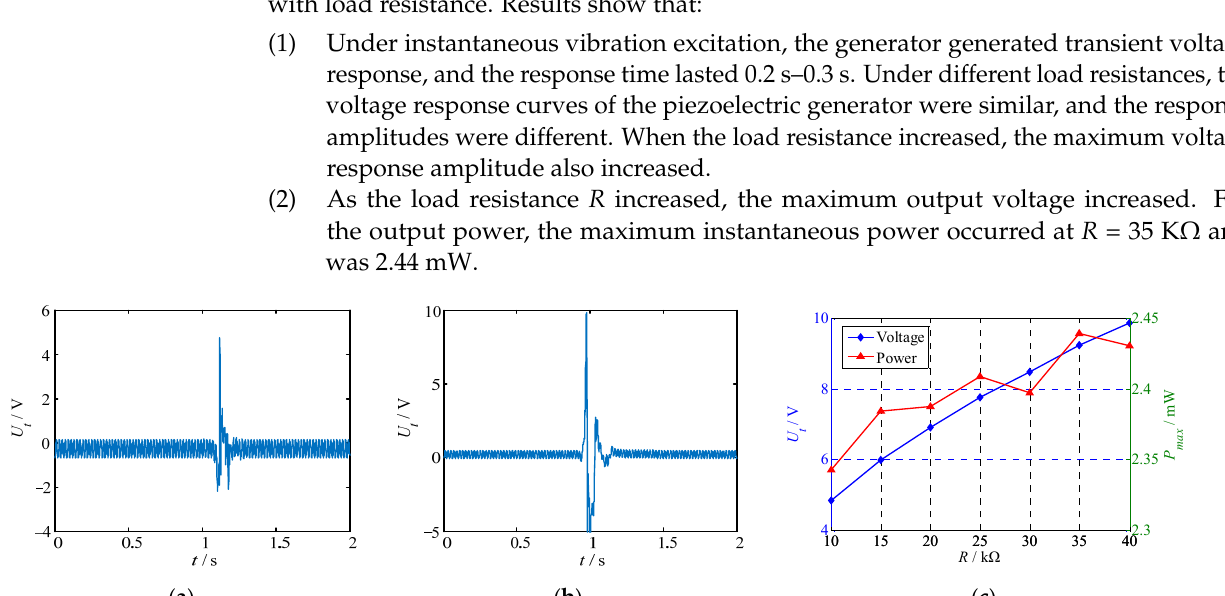
10c shows the instantaneous maximum voltage and maximum power of the generator